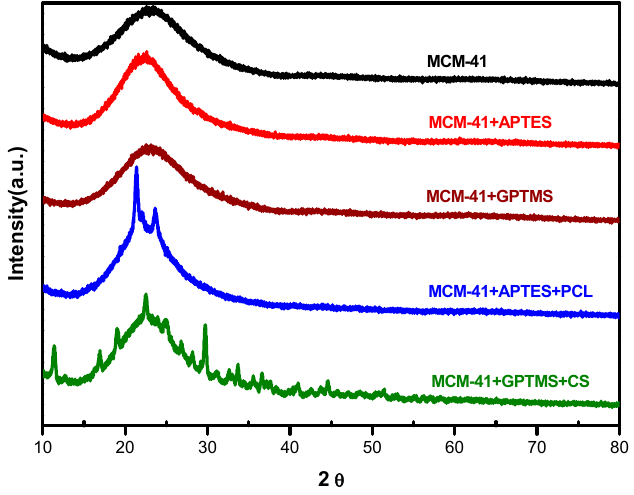
Figure 4. XRD of pure MCM-41 modified with APTES-PCL and GPTMS-CS surface samples.